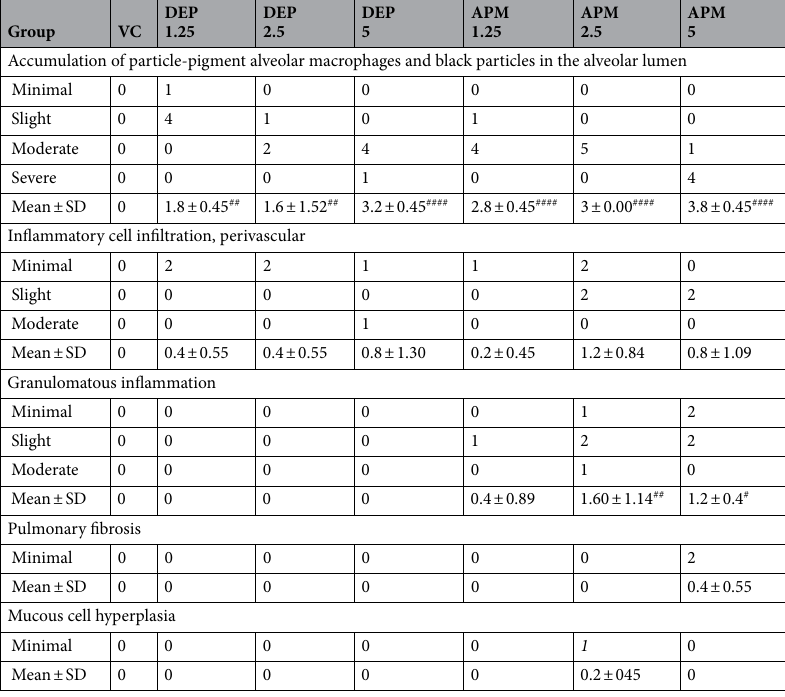
Table 1. Quantitative histopathological assessment of staining sections observed in DEP- and APM-instilled mice. 1, minimal; 2, slight; 3, moderate; 4, severe. Data are presented as mean ± SD from four or five mice per group. DEP diesel exhaust particulate matter, APM artificial matter. # p < 0.05, ## p < 0.01, or #### p < 0.0001 vs.